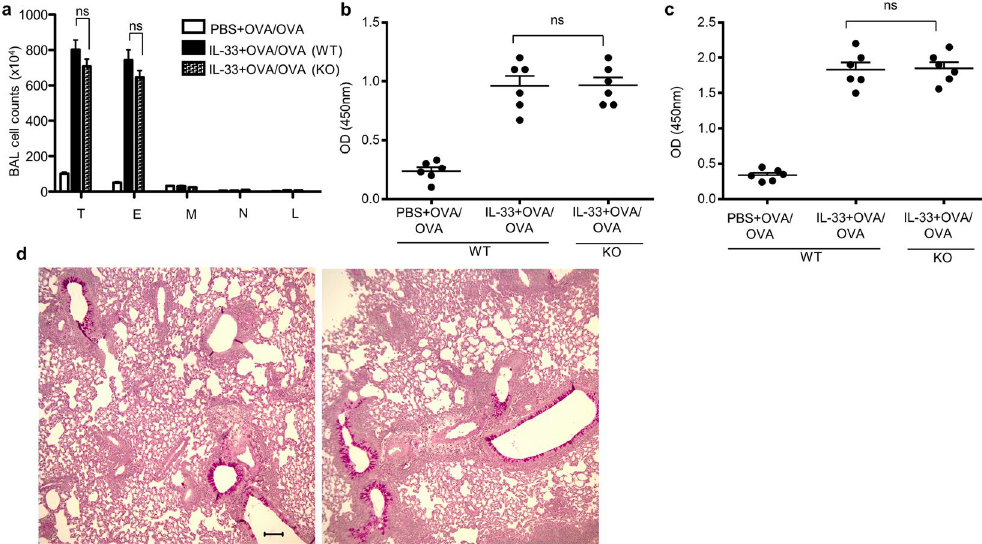
Figure 5. IL-33 is dispensable once skin inflammation develops. Il33 -deficient (KO) or WT mice treated with PBS or IL-33 plus OVA followed by OVA challenge. ( a ) Cell counts in the BAL fluid. ( b ) OVA-specific IgE in BAL fluid. ( c ) OVA-specific IgE in serum. ( d ) Representative lung tissue cross-sections stained with PAS to visualize mucus-producing goblet cells and airway inflammation. Left, WT; right, Il33 KO. Bar, 100 µ m. T, total cells; E, eosinophils; M, macrophages; N, Neutrophils; L, lymphocytes. Data were pooled from two independent experiments (n = 6). Error bars indicate the mean ± SD. ns, not